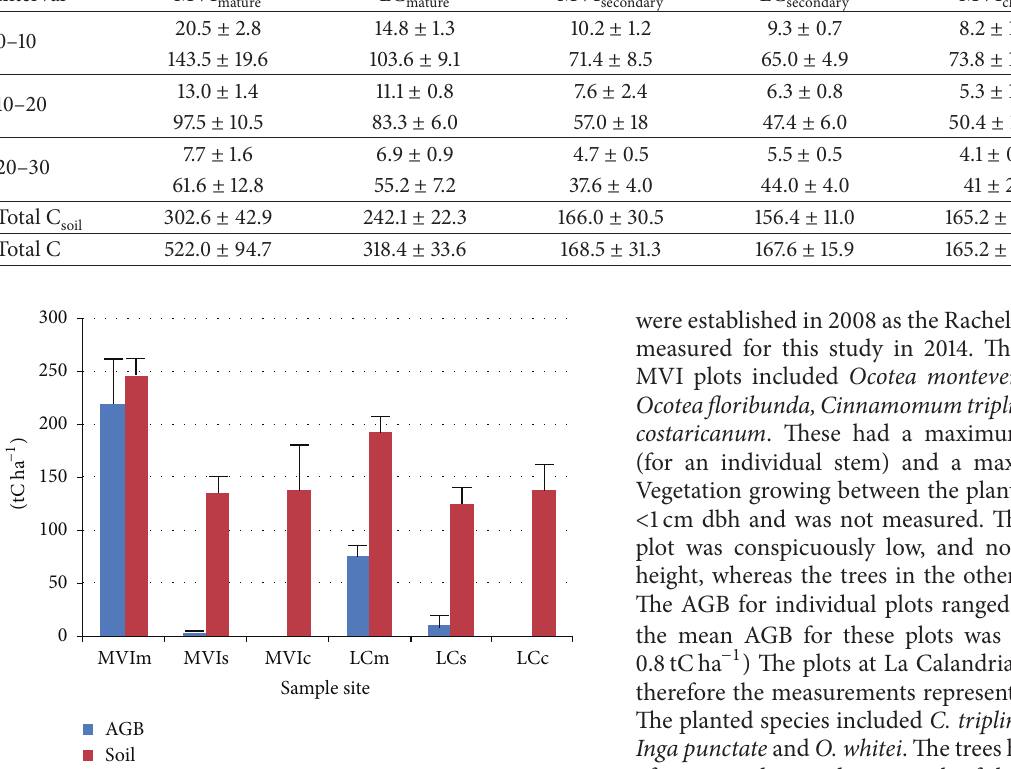
Table 2: Soil carbon data and carbon stocks for mature and secondary forest and clearings at Monteverde Institute (MVI) and La Calandria (LC), with mean C soil % (first line) and soil carbon stock calculated as described in text in tCha −1 (second line) for each 10cm increment in soil for each site. Bottom line is total carbon stock (soil carbon plus AGB carbon ) for each setting tCha −1 . Interval MVI mature